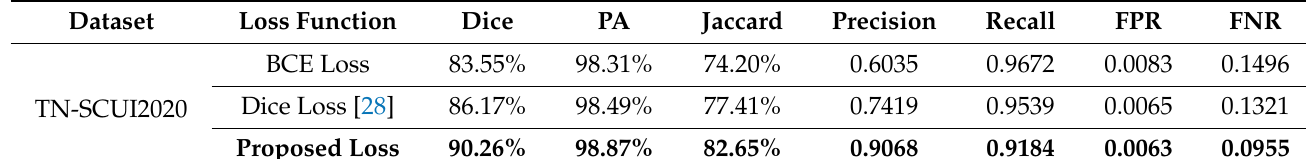
Table 4. Comparison of thyroid nodule segmentation performance using various loss functions.